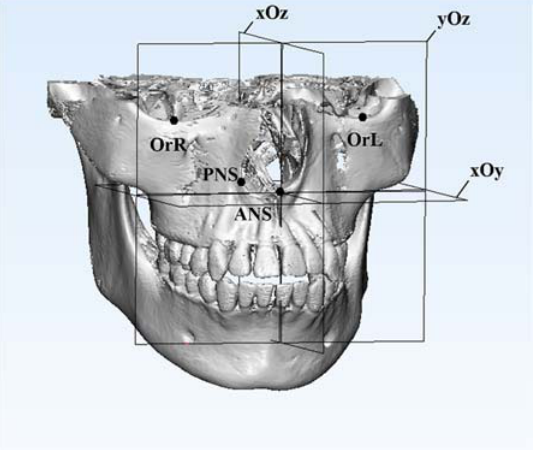
Figure 4. The construction of the maxilla-based coordinate system was based on four basic landmarks: ANS, PNS, OrL and OrR. The ANS point was defined as the origin of the coordinates. The black points are these four basic maxillary landmarks.